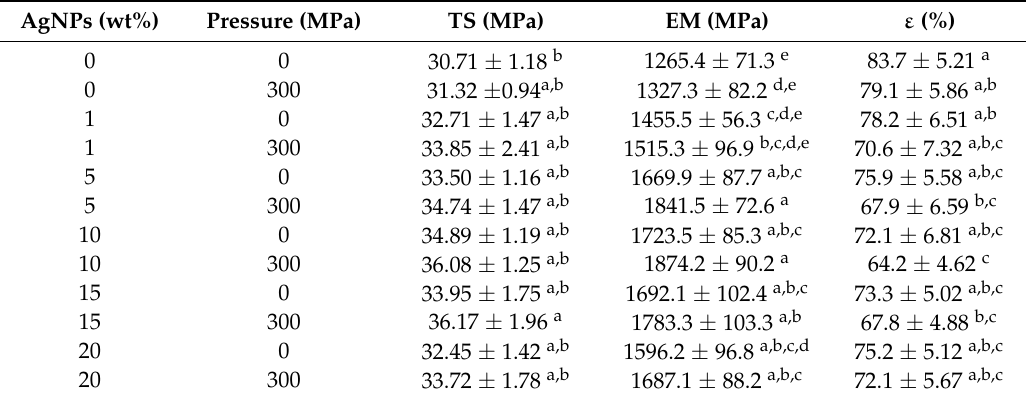
Table 1. The mechanical properties of composite